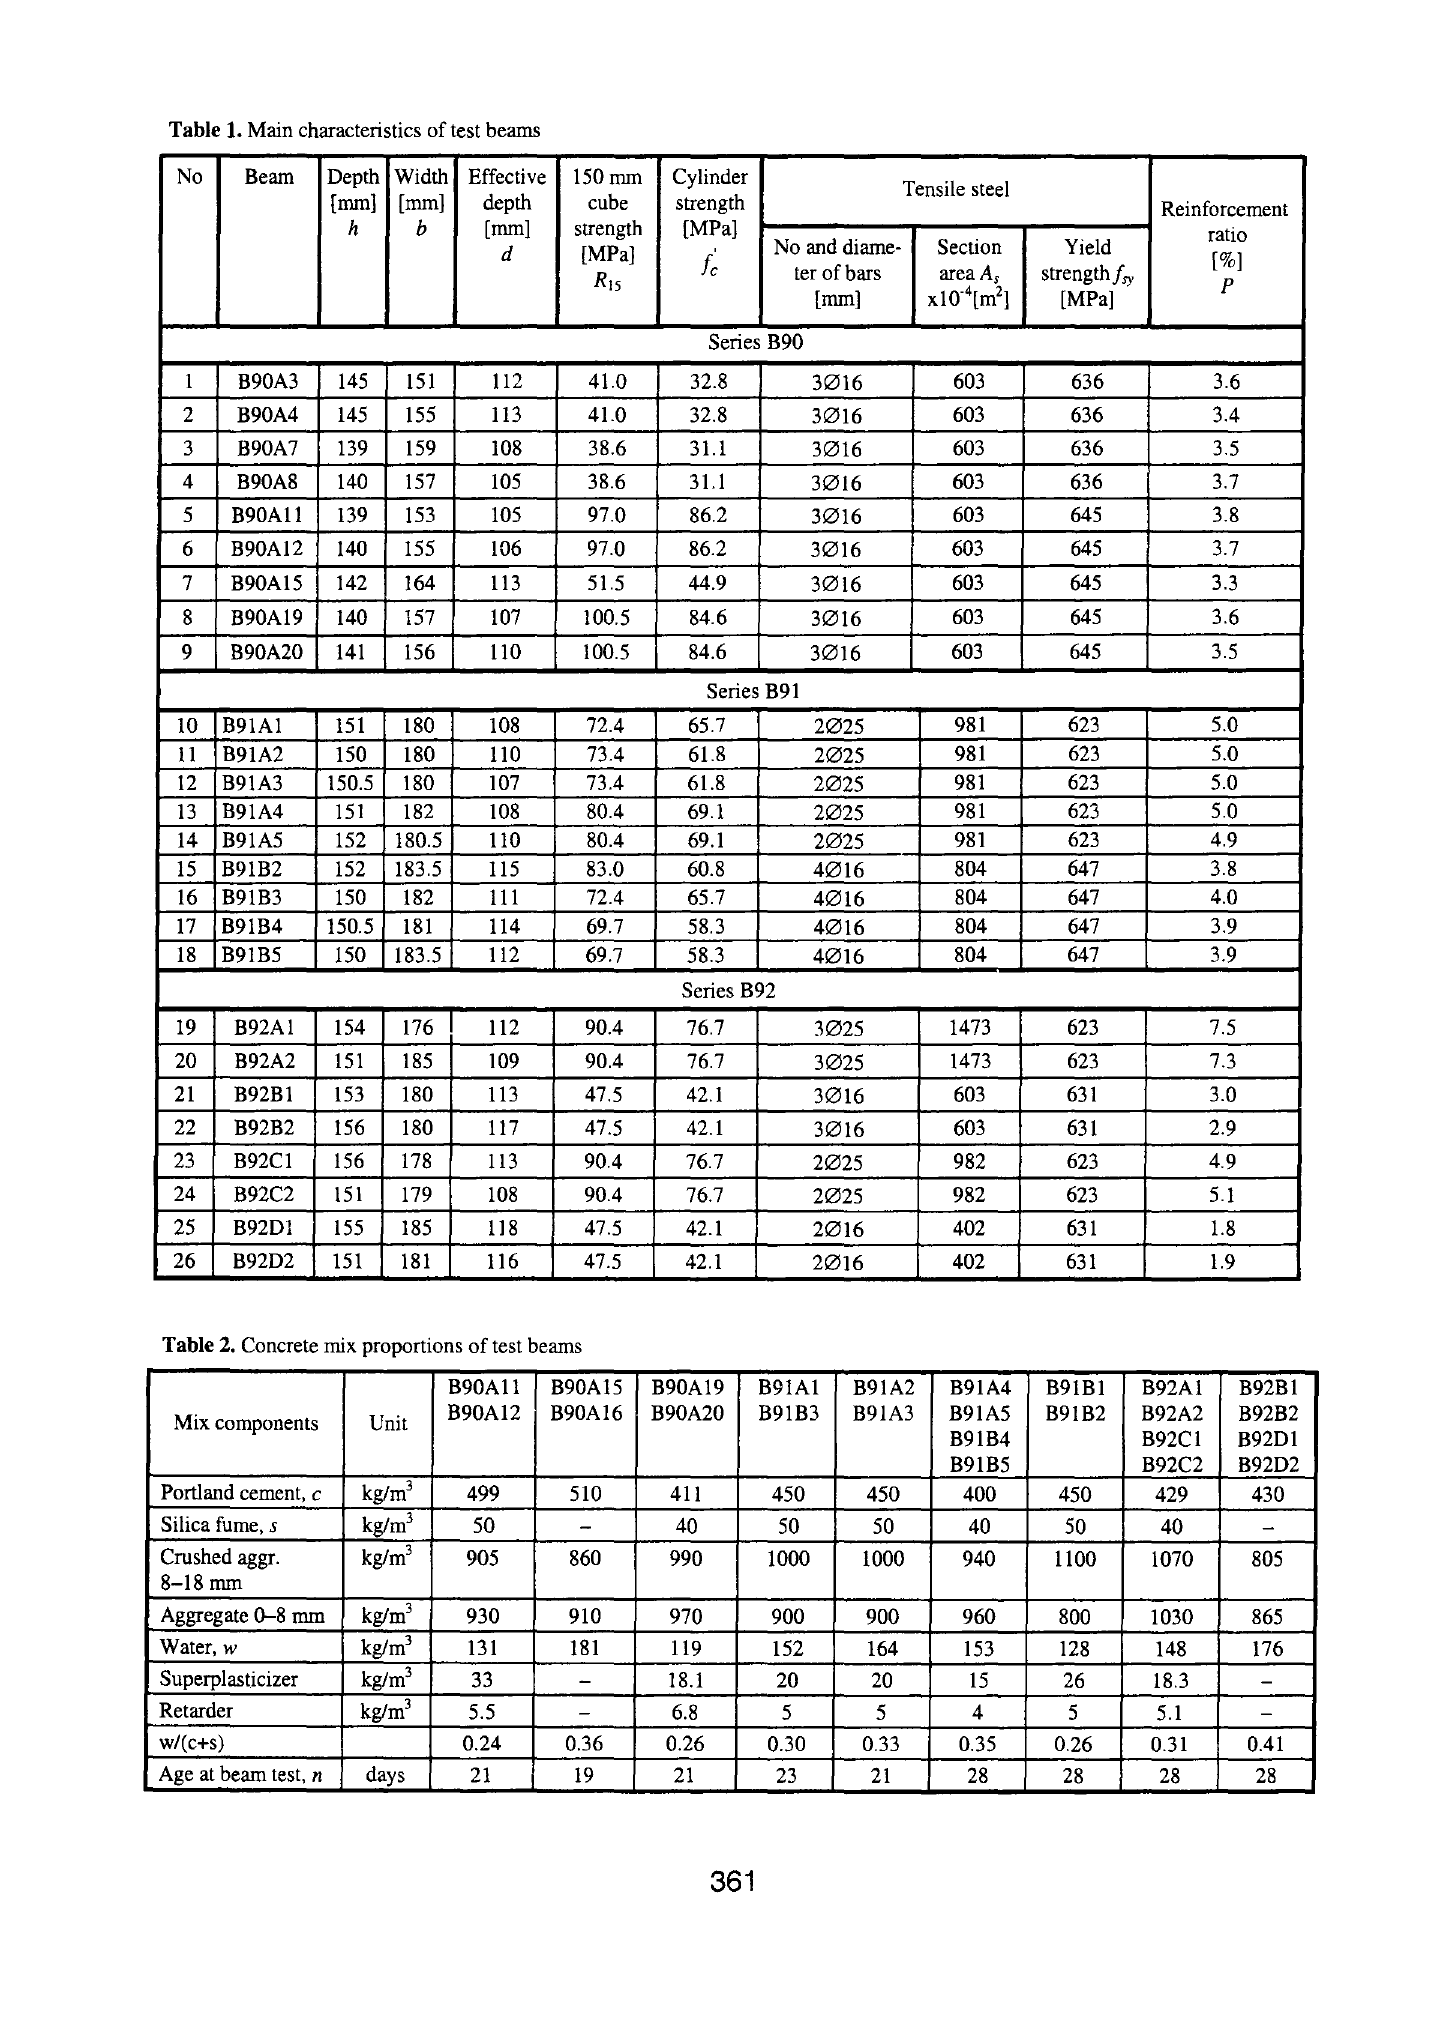
Table 1. Main characteristics of test beams